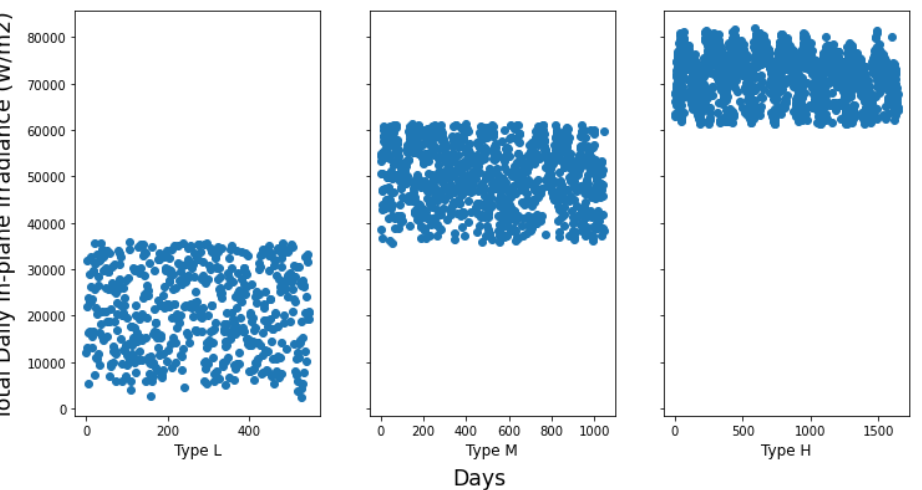
Figure 6. Results of the first classification of the days according to the total daily irradiance value using the k-means algorithm. the k-means